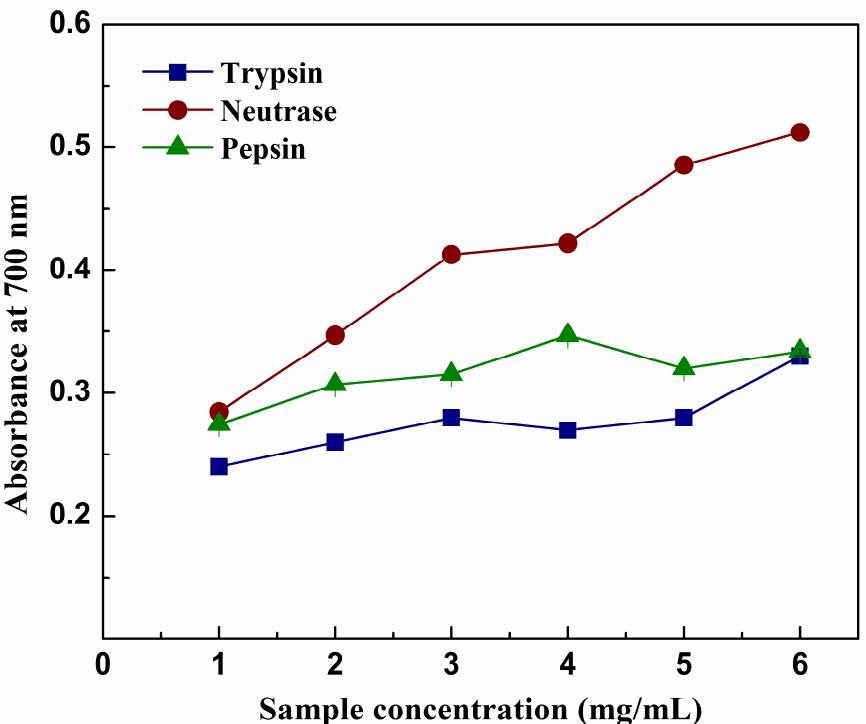
Figure 5. Reducing power of the different hydrolysates during 4 h hydrolysis by trypsin, neutrase and pepsin with different concentrations. Results represent means ± SD of three independent experiments.